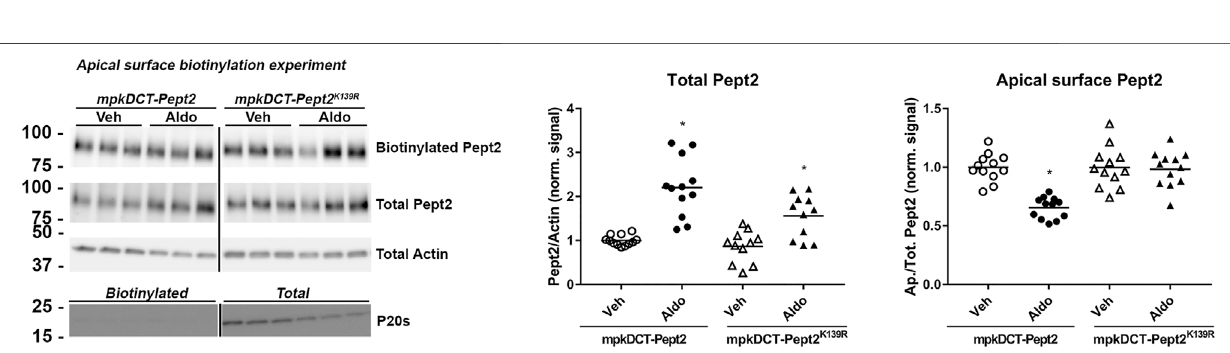
FIGURE 6 | Role of K139 SUMOylation of Pept2 in membrane targeting upon aldosterone treatment. mpkDCT-Pept2 and mpkDCT-Pept2 K139R expressing cells were treated with 1 µM aldosterone for 48 h and subjected to apical surface biotinylation. Samples were probed with anti-FLAG (Pept2), actin and proteosome 20s antibodies. * p < 0.05 in unpaired t -test versus vehicle treatment of same cell line.